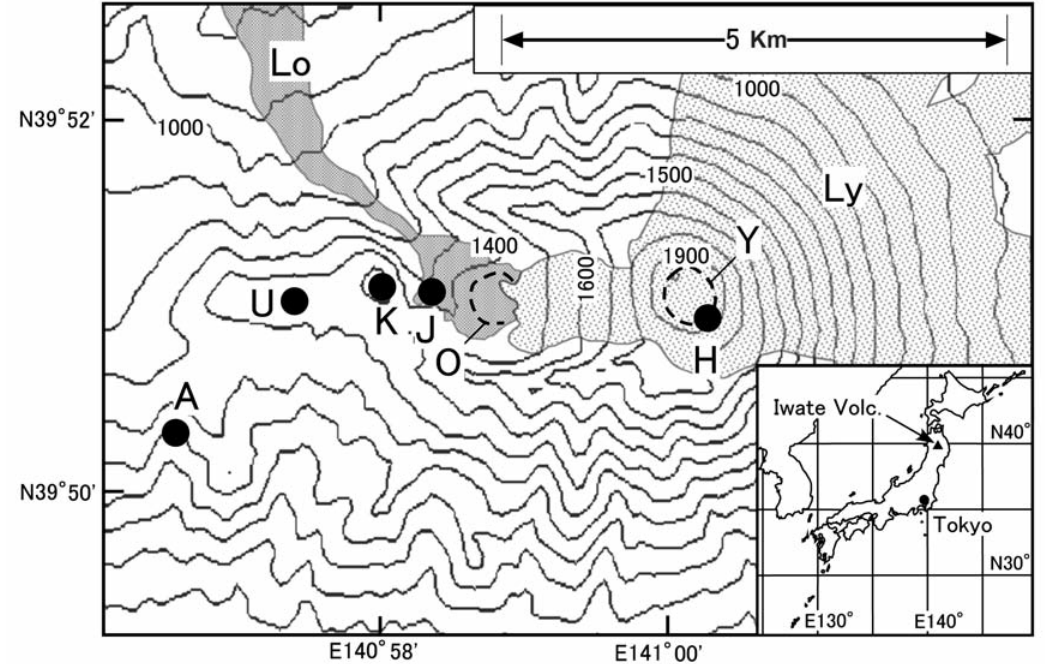
Figure 1. Topographic map of Iwate volcano (contour interval, 100 m; altitude, meters above sea level). Inset, location of the volcano. Dashed curves O and Y, outer rims of the Onawashiro and Yakushidake craters, respectively. Shaded areas Lo and Ly, distribution of the lava flows from the Onawashiro and Yakushidake craters, respectively. Letters H (Higashi iwate), J (Ojigokudani), K (Kurokura), U (Ubakura), and A (Amihari), locations of geothermal areas from which the fumarolic gases were collected. At site J (39°51 ¢ 05 ʺ N, 140°58 ¢ 21 ʺ E), hot spring water was also collected. The area with altered soil at site J measured about 100 m (north–south) by 75 m (east–west). Intense fumarolic activity was noted at J, including a strong smell of sulfur-bearing gases (also detected at site A). At sites H, K and U, in contrast, sulfur-bearing gases were not smelt when sampling the fumarolic